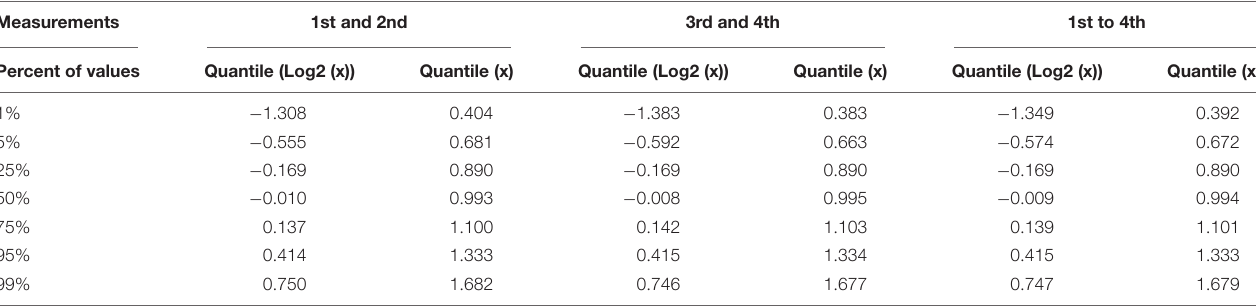
TABLE 1 | Quantil distributions of the x-fold deviation (x) of a value from the mean of two or four values, characterizing the reproducibility of measurements as estimated through technical and biological replicates, respectively. Measurements 1st and 2nd 3rd and 4th 1st to 4th Percent of values Quantile (Log2 (x)) Quantile (x) Quantile (Log2 (x)) Quantile (x) Quantile (Log2 (x)) Quantile